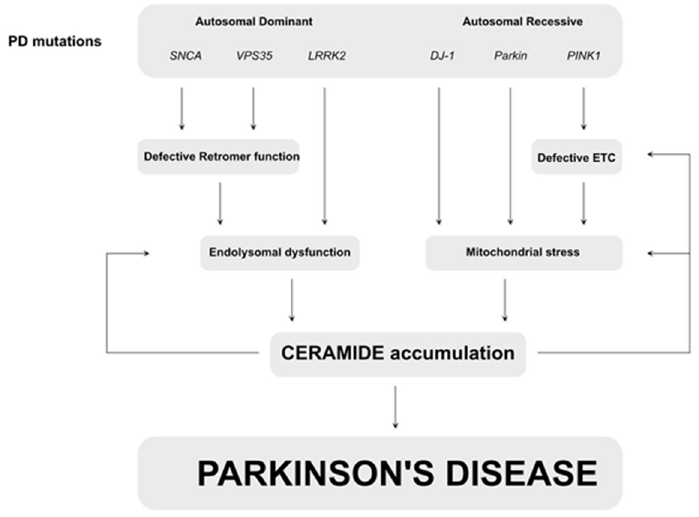
Figure 4. Simplified scheme of mechanisms underlying PD that converge to ceramide accumulation. Mutations in SNCA and VPS35 result in defective retromer function followed by endolysosomal dysfunction. Loss of LRRK2 leads to similar defects. Defects at the level of the endo-lysosome result in accumulation of ceramide. The autosomal recessive PD-related genes Parkin , DJ-1 and PINK1 cause mitochondrial defects via the increased mitochondrial stress which result in ceramide accumulation. Ceramide accumulation has feedback loops that worsen endolysosomal function and mitochondrial stress, creating a viscious cycle that finally results in Parkinson’s disease.